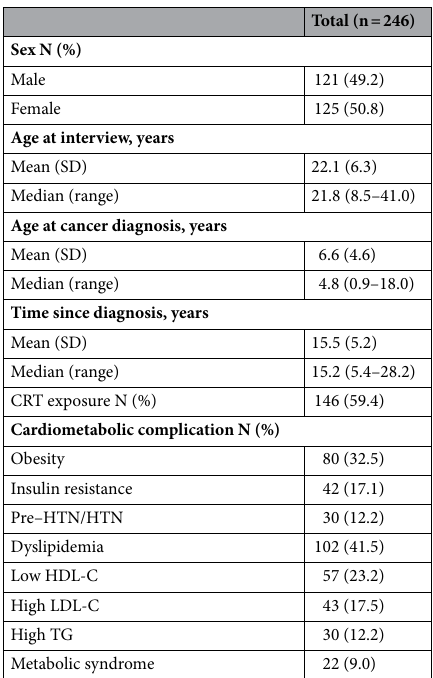
Table 1. Demographic and clinical characteristics of participants. Metabolic syndrome was defined according to the International Diabetes Federation. CRT cranial radiotherapy; HDL-C high-density lipoprotein- cholesterol; HTN hypertension; LDL-C low-density lipoprotein-cholesterol; SD standard deviation; TG